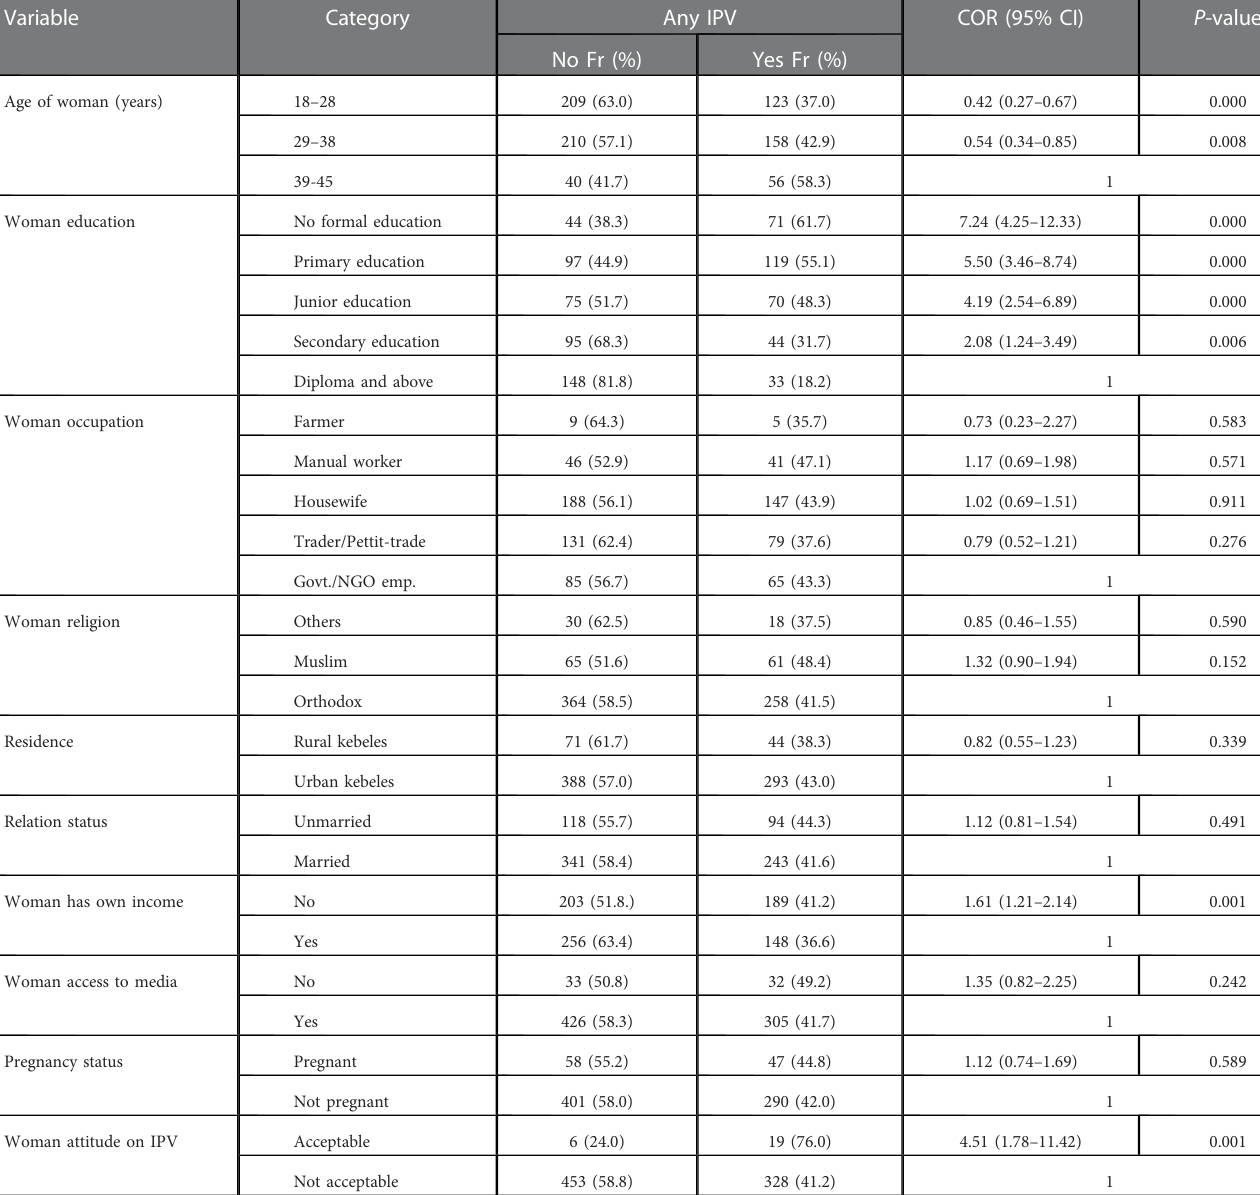
TABLE 5 Bivariate logistic regression analysis of the association of woman-related factors with IPV among women of reproductive age in Debre Berhan town, 2021 ( n =796).